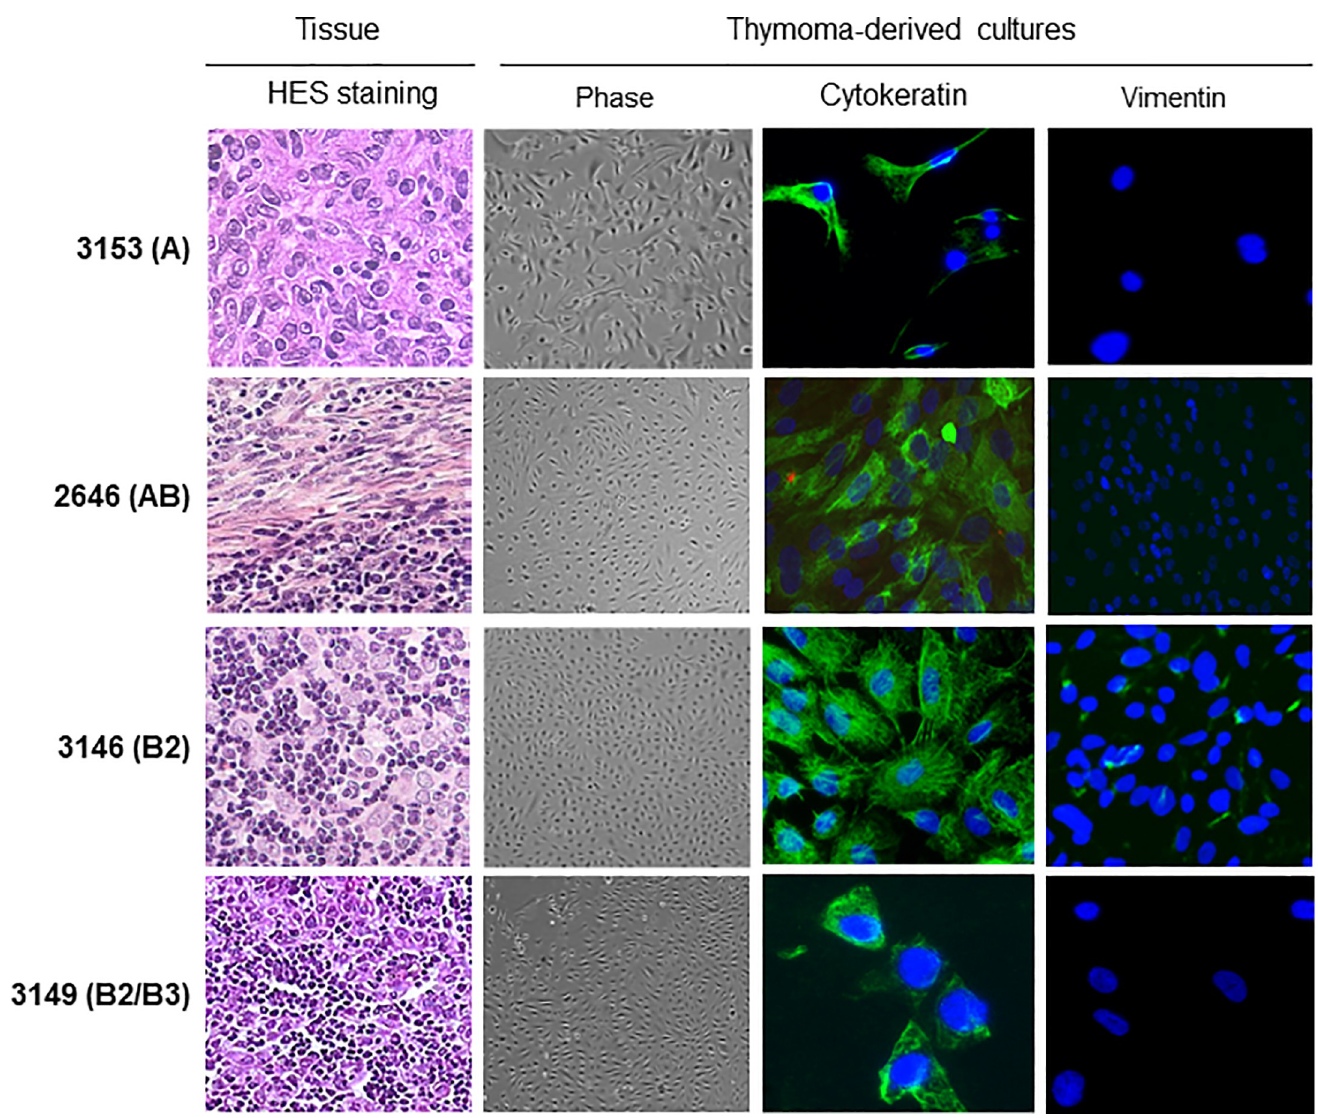
Fig 1. Primary thymic epithelial cells derived from A, AB and B thymomas . Representative cell cultures derived from patients 3153 (pleural metastasis of A thymoma), 2646 (AB thymoma), 3146 (B2 thymoma) and 3149 (B2/ B3 thymoma). HES (hematoxylin- eosin- saffron) staining were used to characterize the thymic tissues. Thymoma-derived cells were observed daily by phase microscopy and stained for their expression of cytokeratin and vimentin. Nuclei stained with DAPI